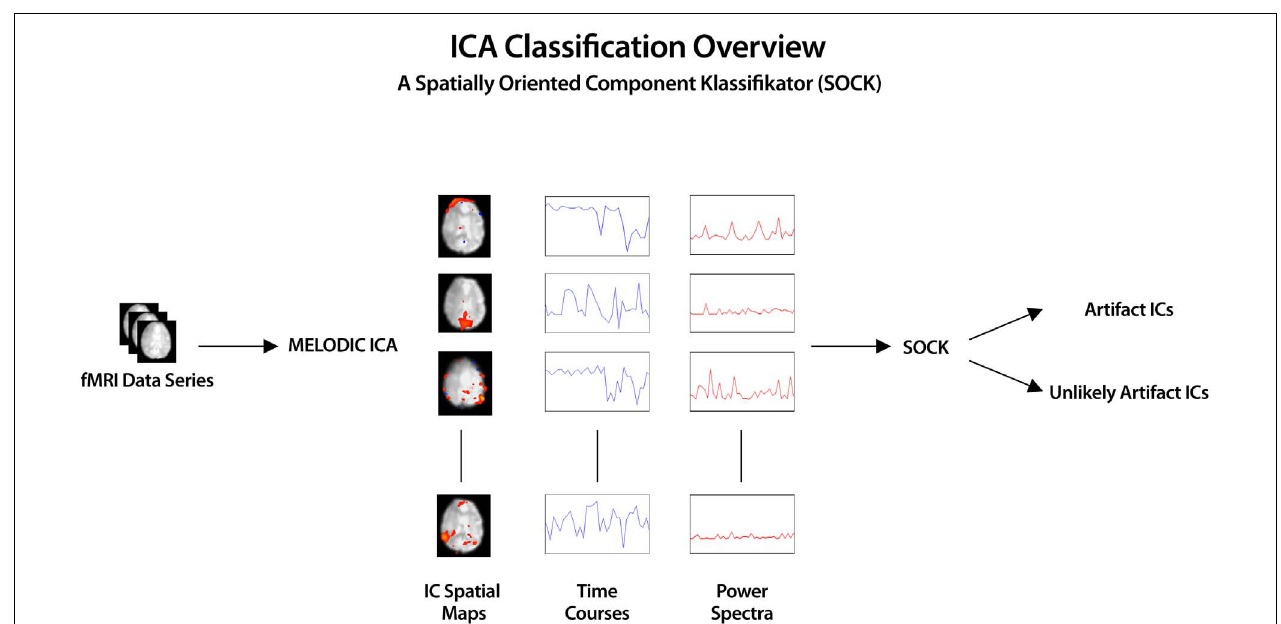
category) and those containing possible neuronal signal (Unlikely Artifact category) by calculating IC features (smoothness measure, edge, CSF, and temporal frequency